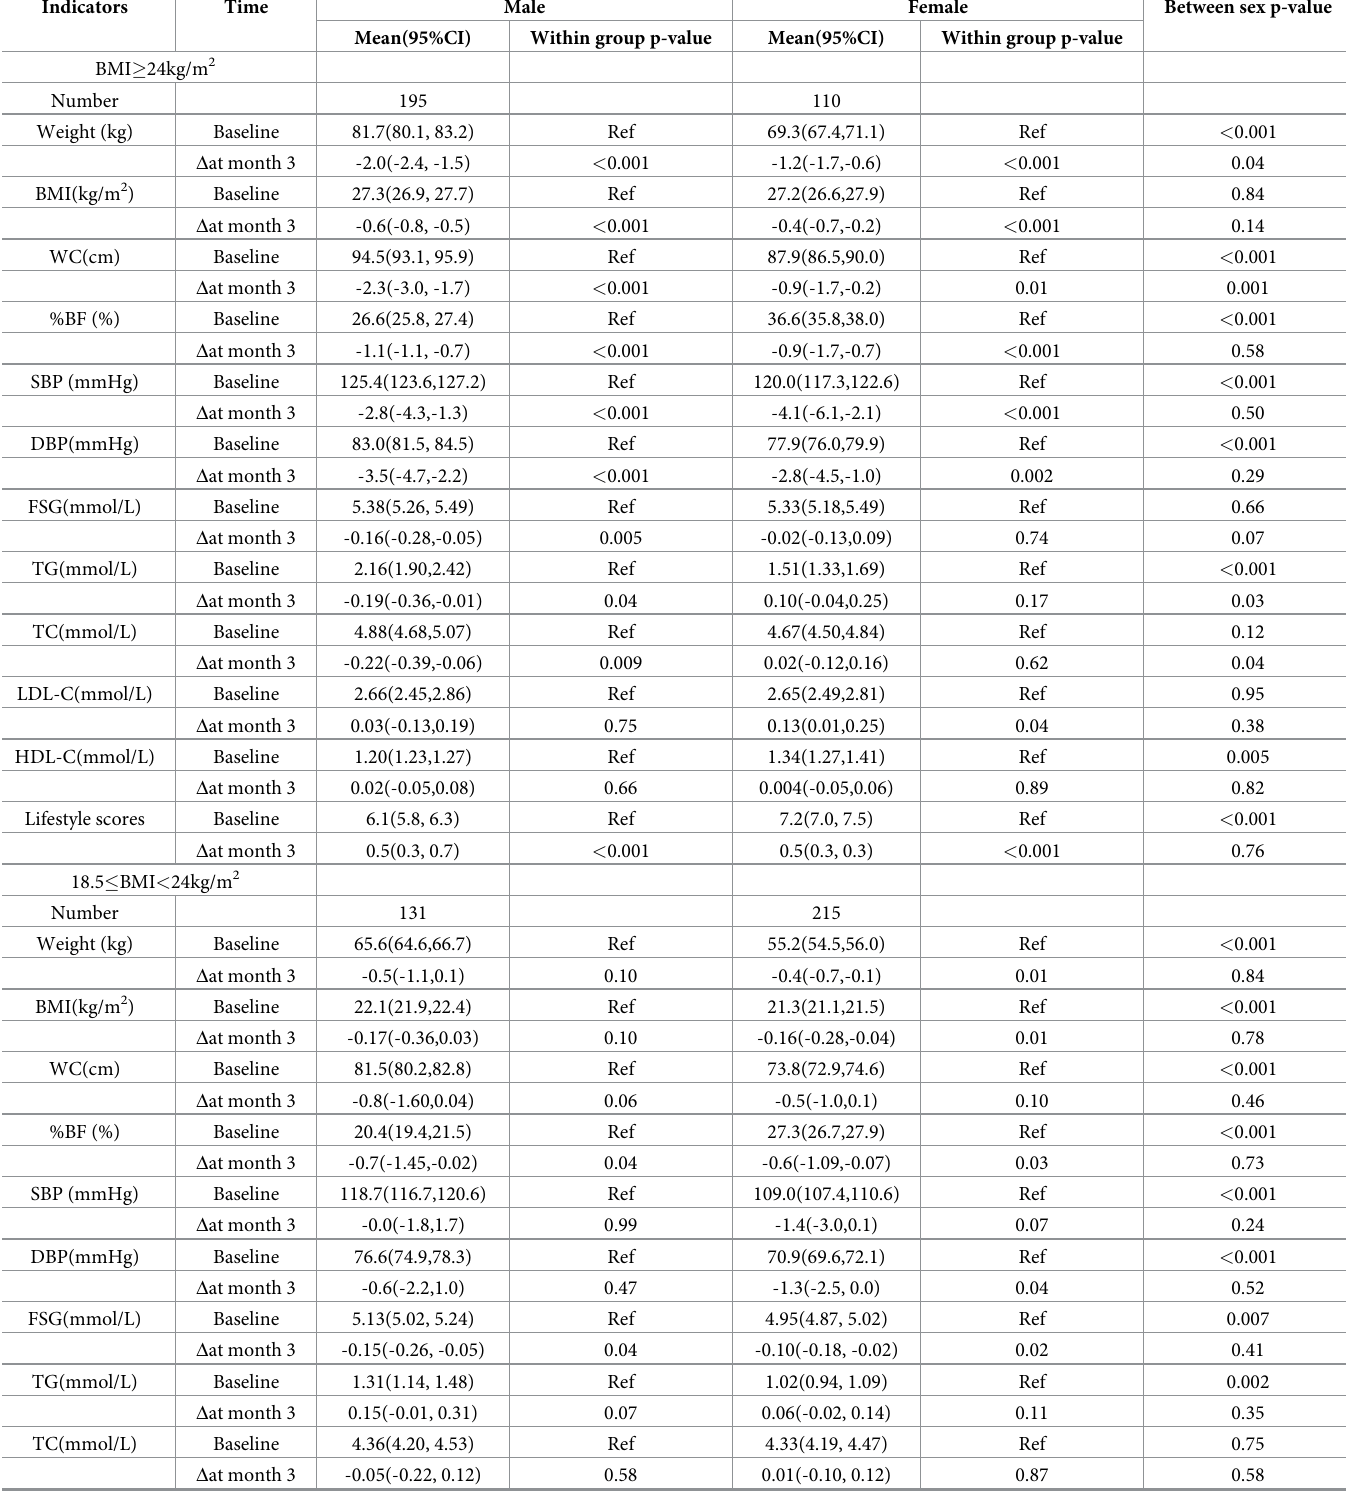
Table 2. Baseline and changes in outcomes variable at 3 months for different BMIs’